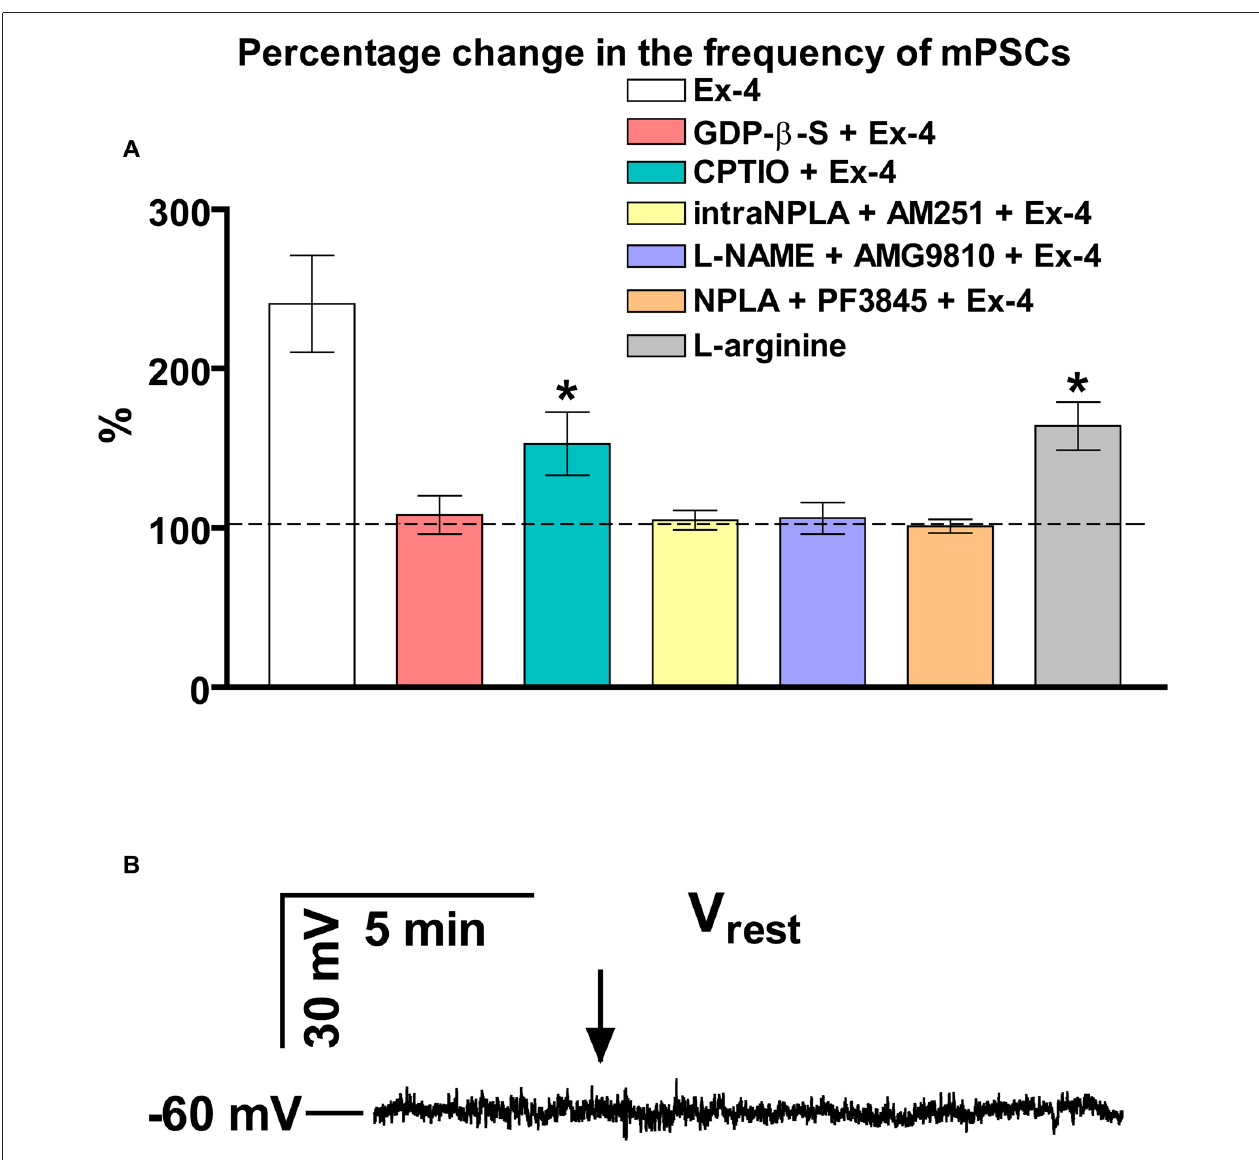
FIGURE 4 | Summary graph of data demonstrating direct action of Exendin-4 and resting potential measurement. (A) Bar graph reveals that elevation of the frequency of mPSCs resulted from direct activation of GLP-1R in GnRH neurons. This action activates a NO-signaling machinery and involves an anandamide-TRPV1-coupled mechanism. The Exendin-4 data were taken from Figure 2 for an easier comparability. (B) Exendin-4 does not affect resting membrane potential (V rest ) in GnRH neurons. Arrow shows onset of the Exendin-4 application. ∗ p <